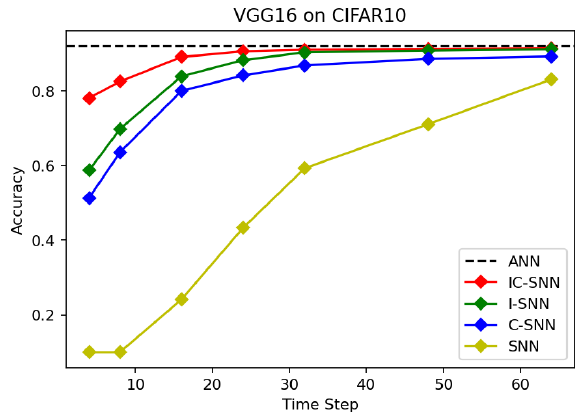
Figure 5. VGG16 on CIFAR10